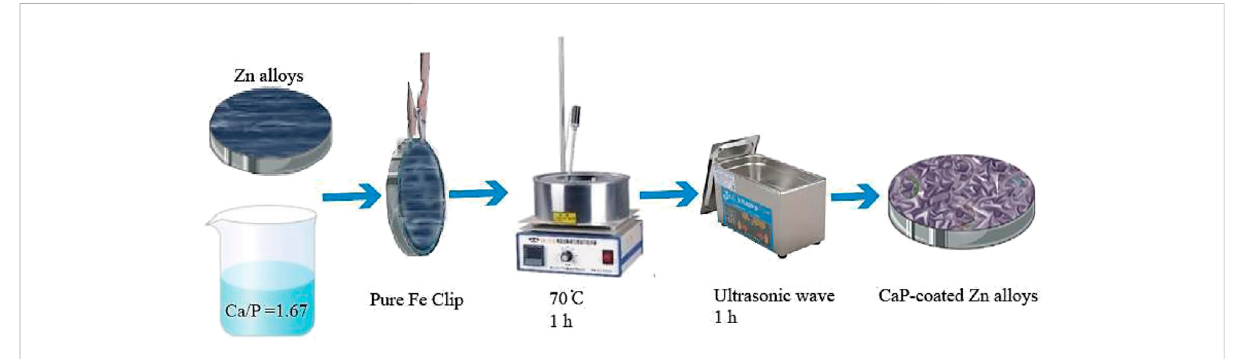
FIGURE 2 Flow diagram of the experimental